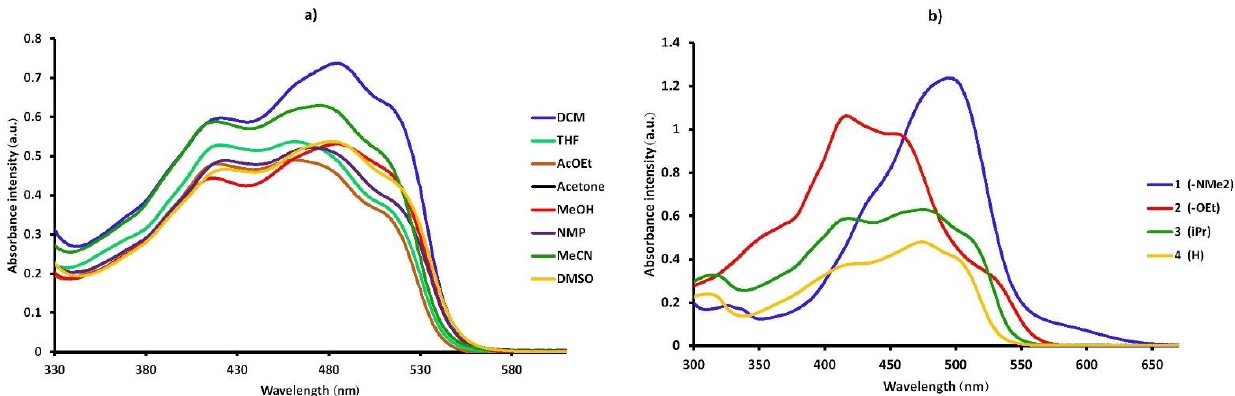
Figure 1. The normalized UV–Vis absorption of main bands ( a ) and fluorescence ( b ) spectra of 1–4 in DMSO.